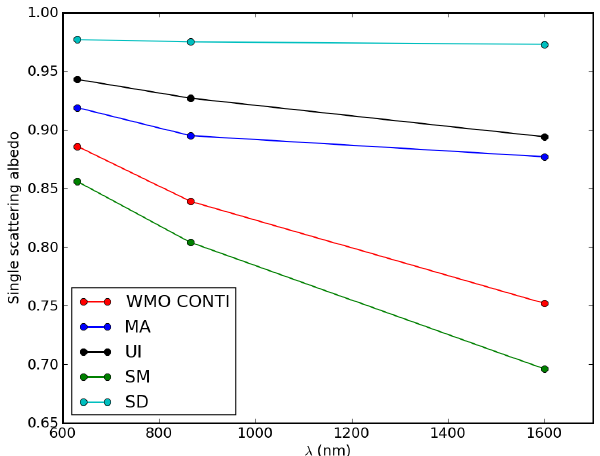
Fig. 2. Single scattering albedo ( $ 0 ) for the 5 aerosol models used by the algorithm to retrieve the AOT at 0.6µm.